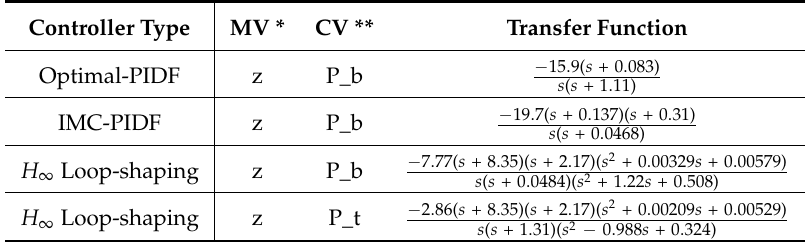
Table 7. Transfer functions of all the controllers developed on the low-dimensional